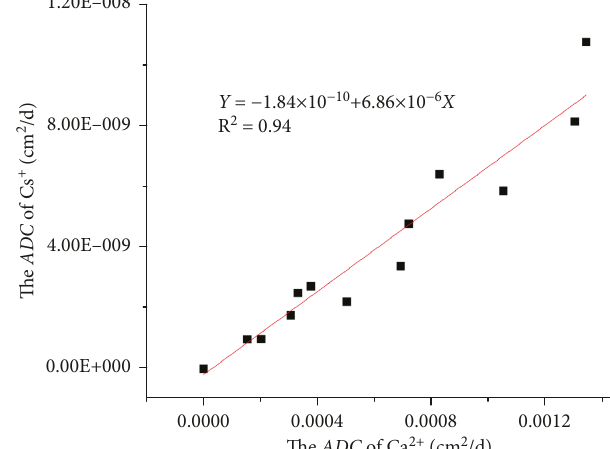
Figure 13: The relationship of ADC between Ca 2+ and Cs + in fly ash/cement waste